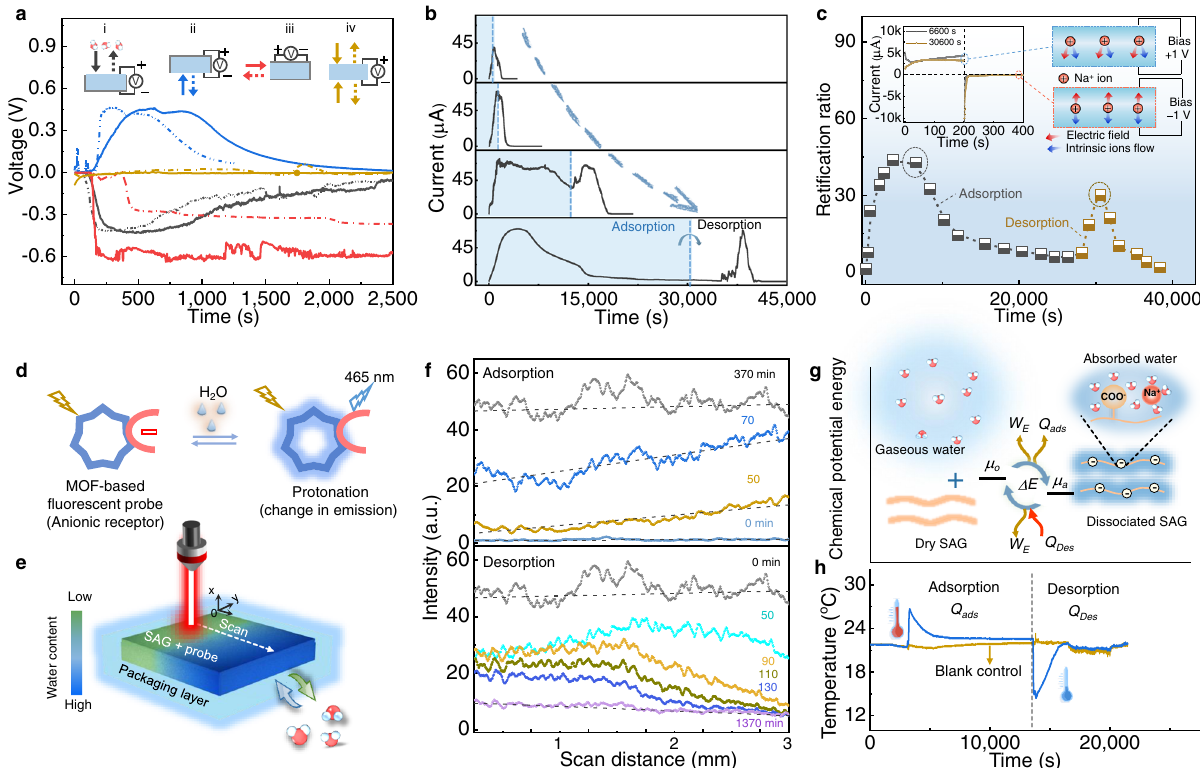
Fig. 6 Demonstration of working mechanism and discussion of energy sources. a Electric signal of MADG in response to moisture sources in different directions. Insets are schematic illustrations of four directions of moisture source interacted with MADGs. b The current-time pro fi le in the electricity generation with various adsorption time. c The variation of ions recti fi cation ratio of MADG under an alternating bias of ±1 V during adsorption and desorption process (40 °C). Insets are current response curves and the schematic diagram of ions transport. d Scheme of the mechanism of water detection by fl uorescence sensing. The probe is a type of luminescent metal-organic framework. A trace of water is absorbed in the pores of metal-organic framework-based probe, resulting in its protonation and turn-on blue fl uorescence (465 nm). e Illustration of experimental set-up of CLSM testing. f Distribution of fl uorescence intensity along with scanning direction during adsorption and desorption. g Schematic illustration of proposed energy input and conversion involved in MADG. The μ o and μ a represents the total chemical potential energy of both gaseous water molecules and dry SAG fi lm, as well as dissociated SAG fi lm with adsorbed water, respectively. The Δ E, W E , Q Ads , and Q Des denotes as the variation of chemical potential energy,